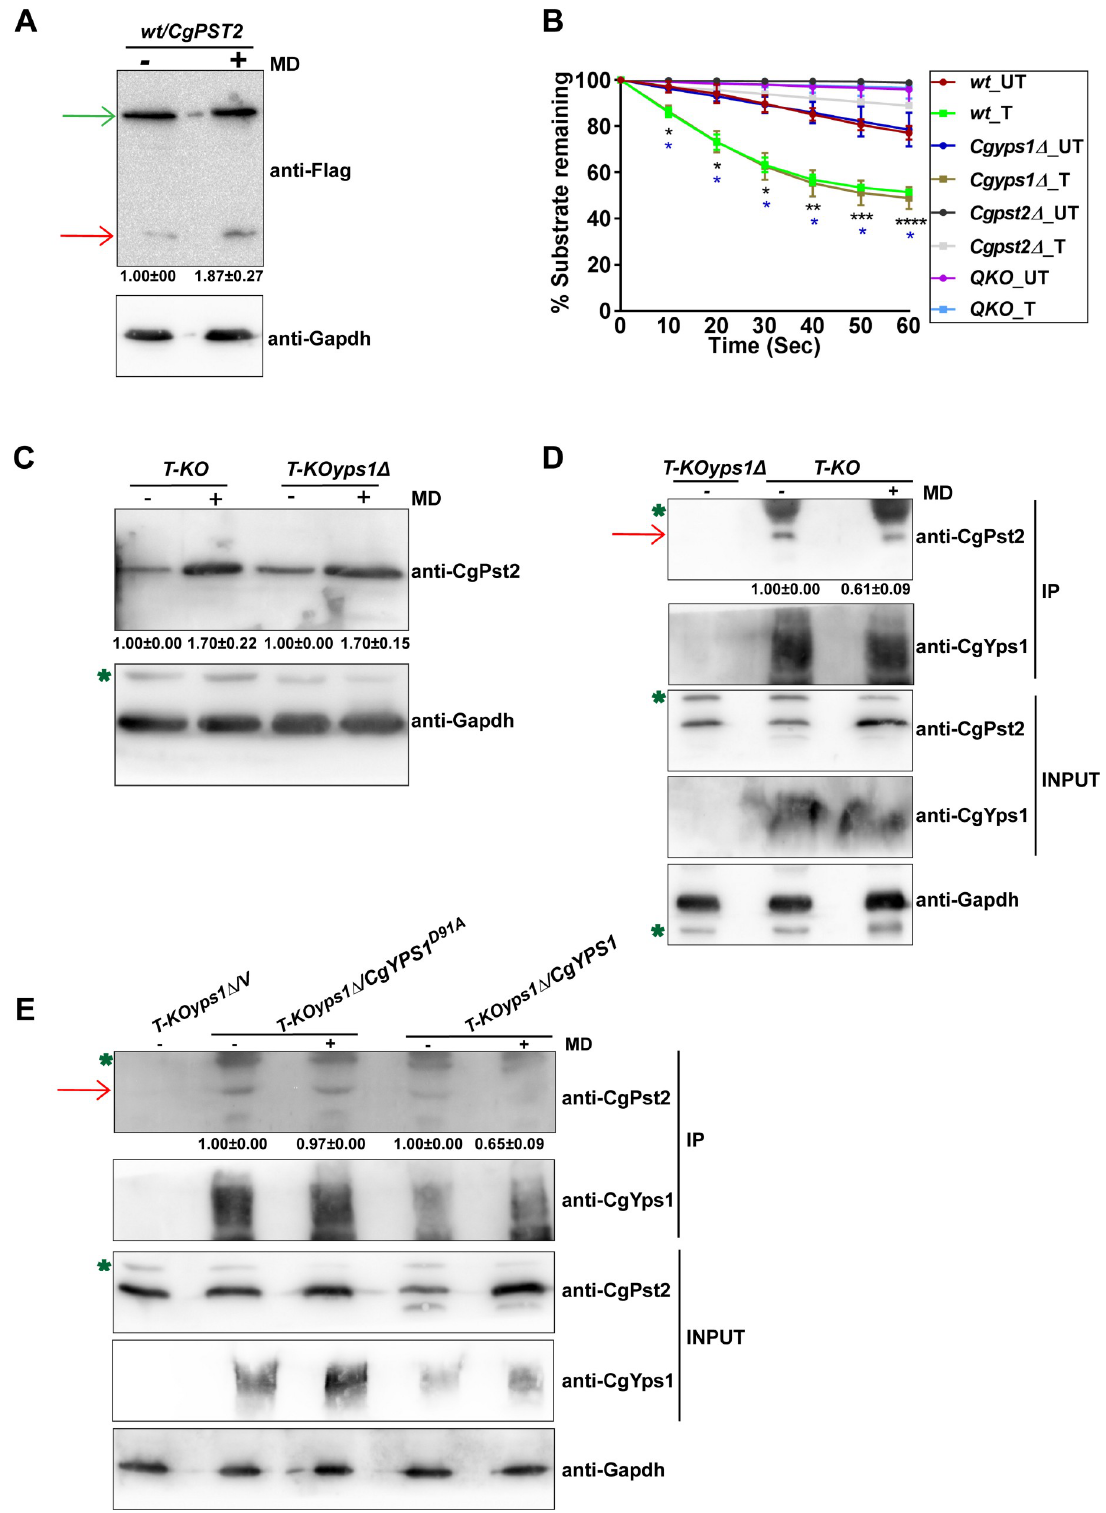
Fig 4. The cleavage and NADH:quinone oxidoreductase activity of CgPst2 is increased upon menadione treatment. A. Immunoblot analysis of CgPst2 expression, using anti-Flag antibody, in cell extracts of untreated or menadione-(MD; 90 μ M for 90 min)-treated log- phase cells of the wt strain expressing CgPst2-SFB, using anti-Flag antibody. CgGapdh was used as a loading control. The intensity of the